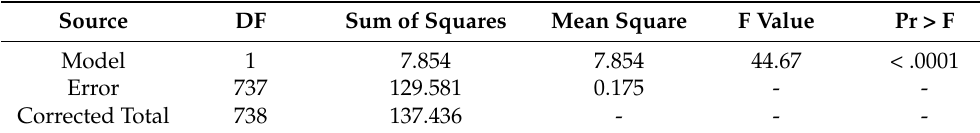
Table 15. ANOVA table for stem diameter.